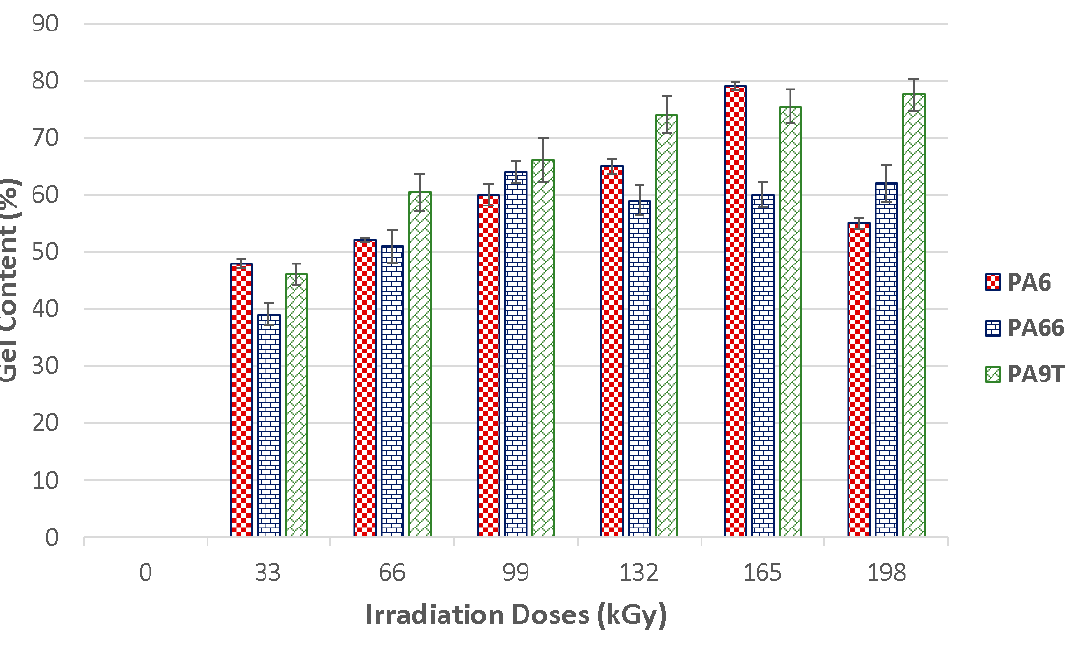
Figure 14. Gel content of irradiated PA 6, PA 66 and PA 9T.